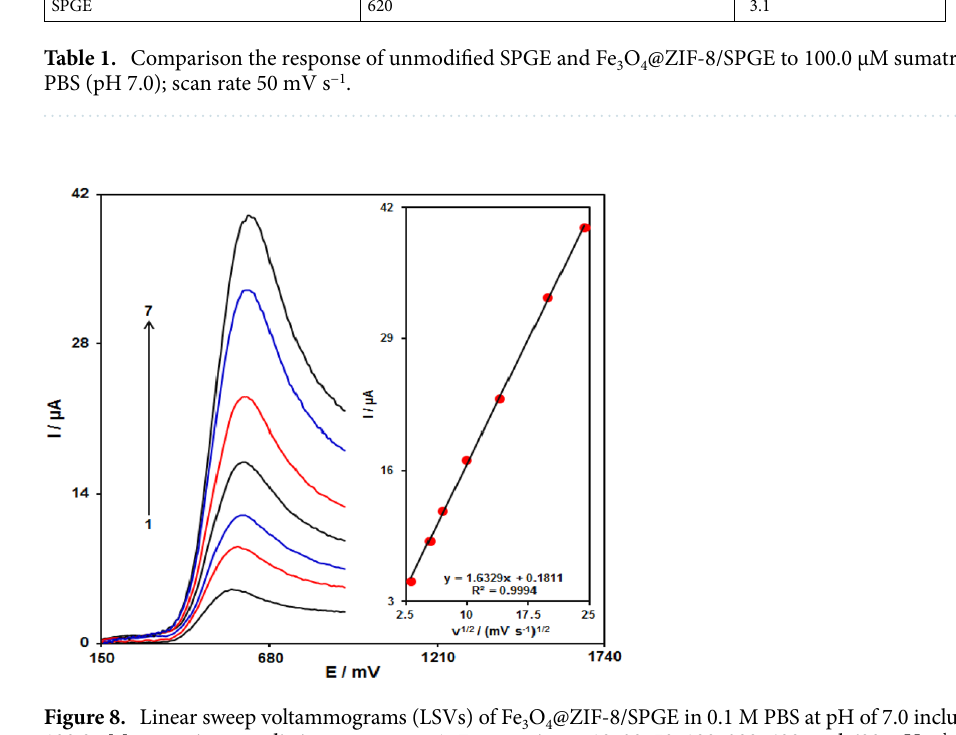
Figure 8. Linear sweep voltammograms (LSVs) of Fe 3 O 4 @ZIF-8/SPGE in 0.1 M PBS at pH of 7.0 including 100.0 µΜ sumatriptan at distinct scan rates; 1–7 respective to 10, 30, 50, 100, 200, 400, and 600 mV s −1 . Inset; variations in the anodic peak currents versus ν 1/2